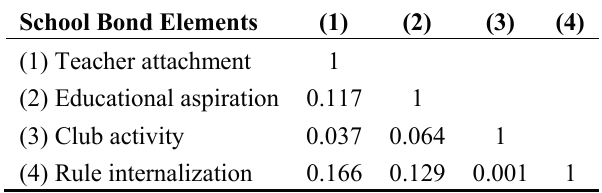
Table 2. Pearson correlations among school bond elements at